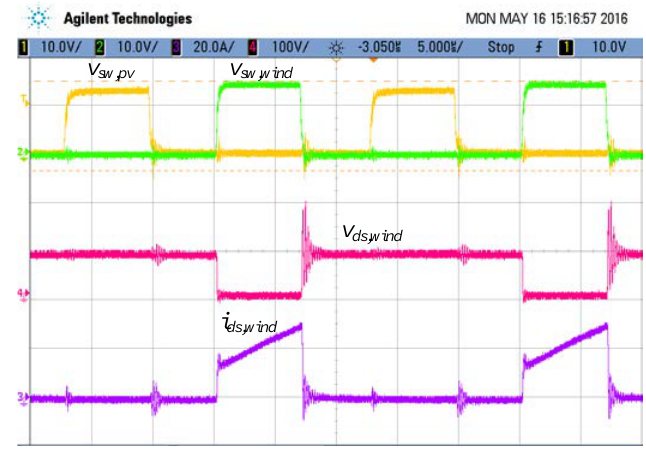
Figure 9. Measured waveforms of active switches at wind-turbine input port while the output power is 1 kW ( v sw,wind : 10 V/div, v sw,pv : 10 V/div, v ds,wind : 100 V/div, i ds,wind : 20 A/div, time: 5 μs/div).